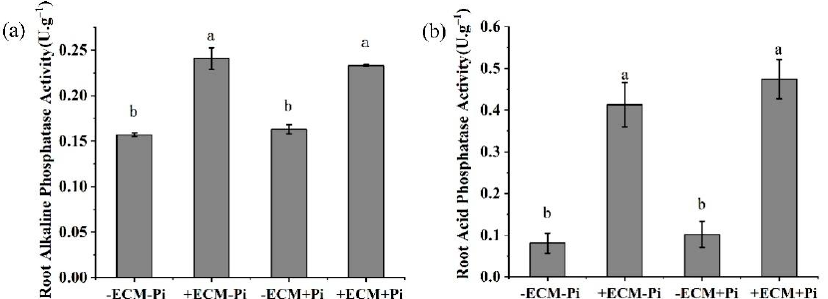
Figure 4. The effects of ECMF inoculation and Pi levels on root acid and alkaline phosphatase activities of the C. henryi seedlings. -ECM-Pi: uninoculated and low Pi; -ECM+Pi: uninoculated and high Pi; +ECM-Pi: inoculated and low Pi; +ECM+Pi: inoculated and high Pi. ( a ) Root alkaline phosphatase activity of each treatment; ( b ) root acid phosphatase activity of each treatment. The error bars refer to standard deviation. Different letters among treatments indicate significant differences ( p < 0.05) according to Duncan’s multiple range